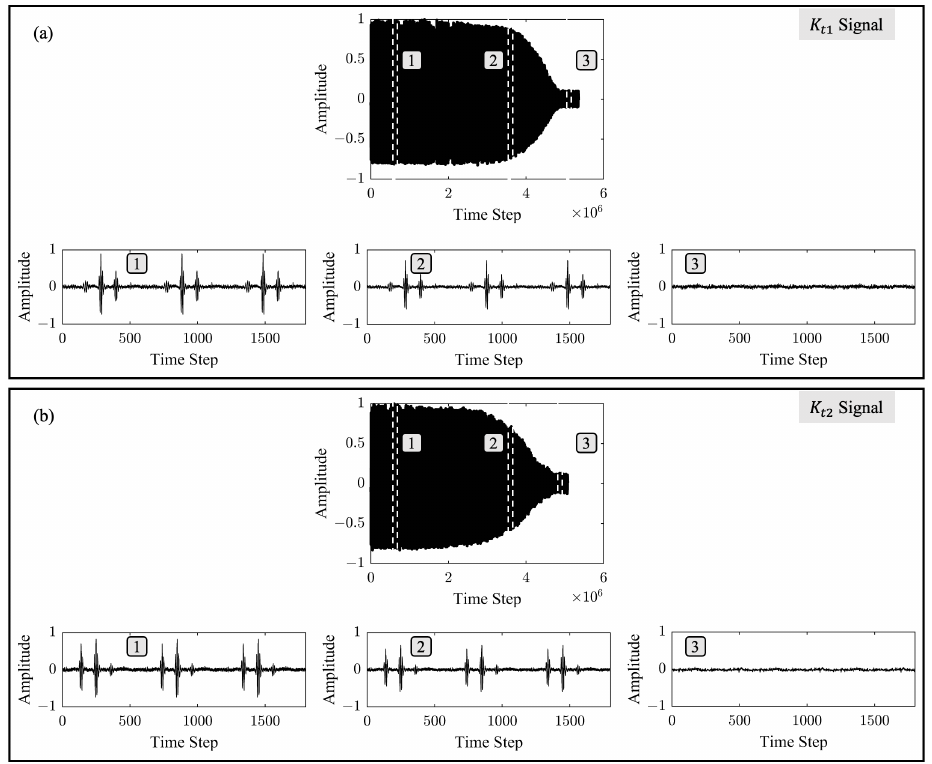
Figure 6. Concatenated Ultrasonic Signal for ( a ) K t 1 and ( b ) K t 2 . Three zoomed-in windows attributed as 1, 2, and 3 are shown in the corresponding